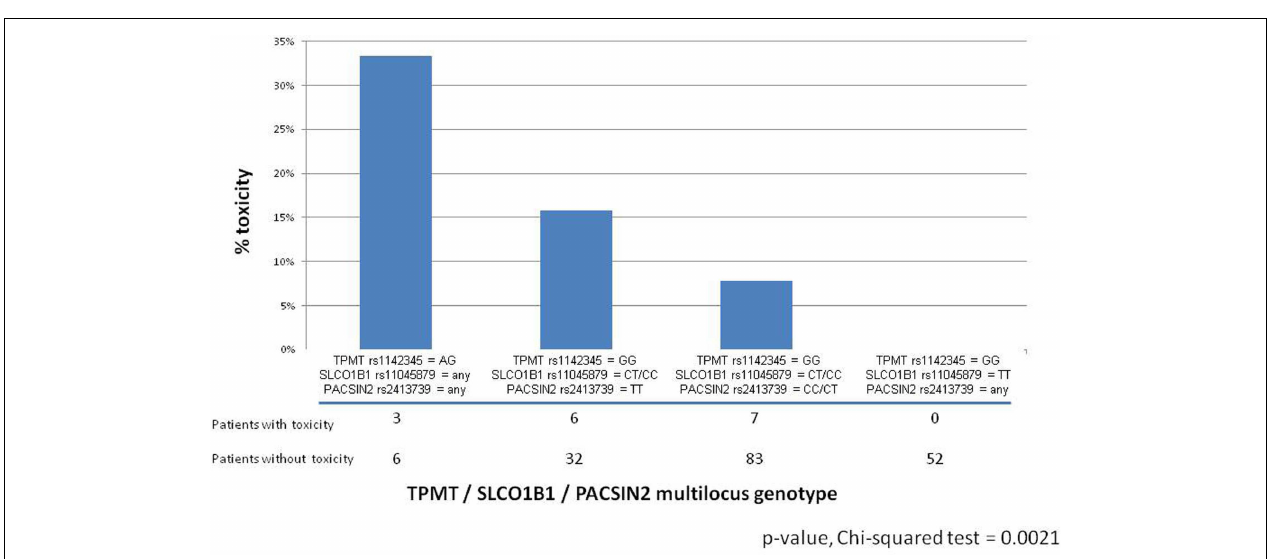
FIGURE 1 | Barplot reporting the percentage of patients developing severe (Grade 3-4) GI toxicity during consolidation therapy in patients withALL treated according to the St JudeTotal 13B protocol as a function ofTPMT rs1142345 / SLCO1B1 rs11045879 / PACSIN2 rs2413739 multilocus genotype (Stocco et al.,